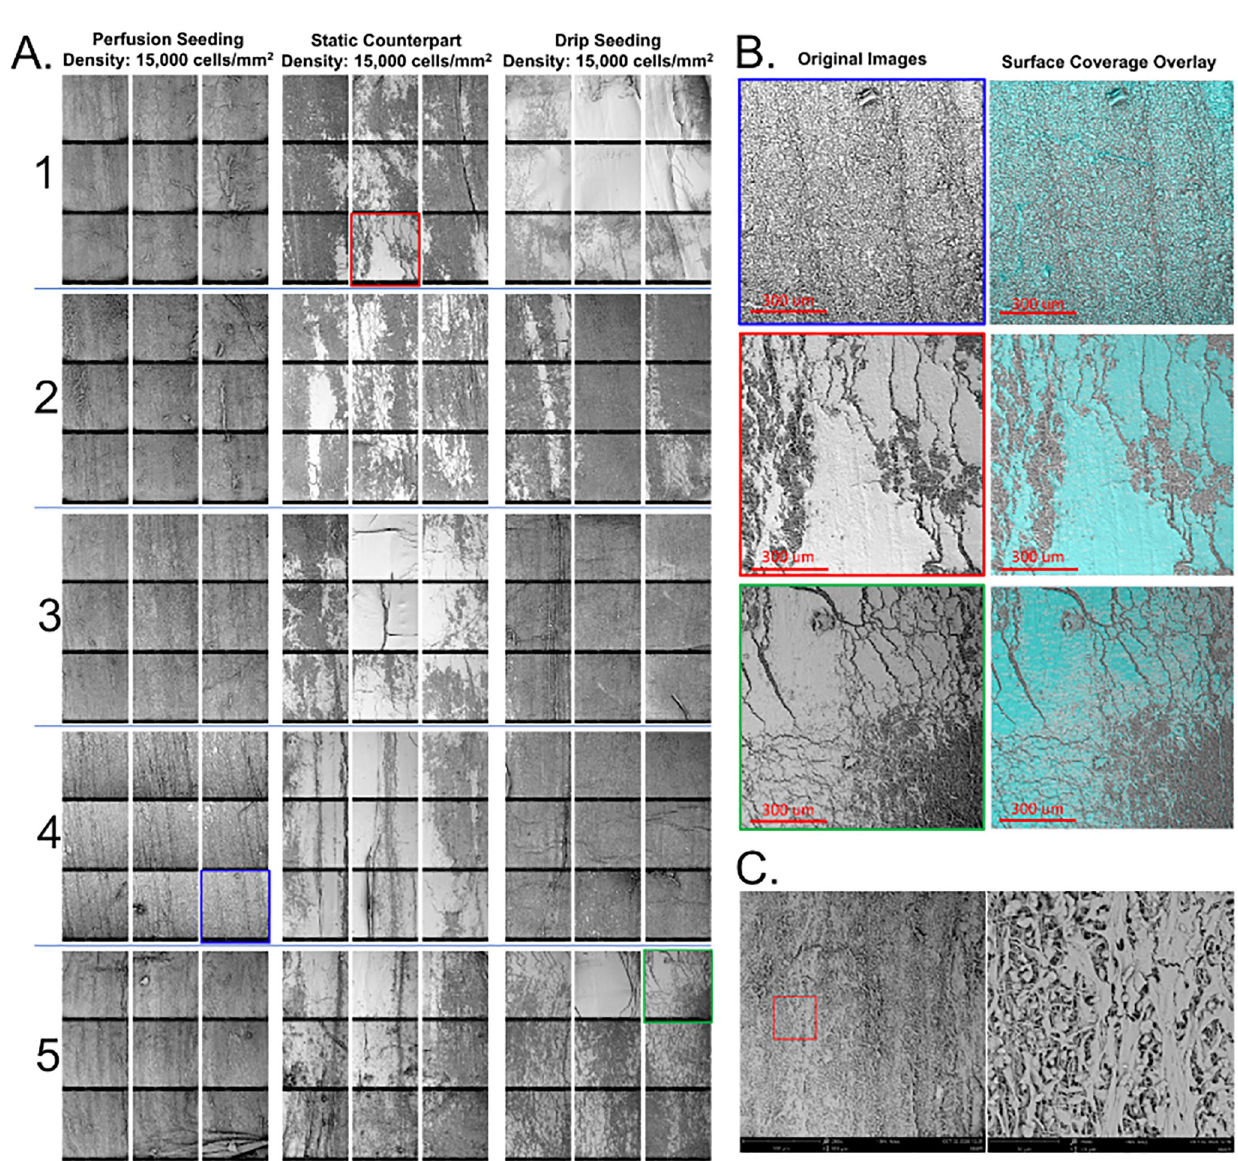
Fig 8. Interpretation of SEM images. (A) Representative SEM images of luminal surface of seeded electrospun PCL scaffolds for each seeding method, (B) Sample images representing quantitative analysis of luminal surface coverage per method. (C) Zoomed in view of perfusion seeded scaffold.